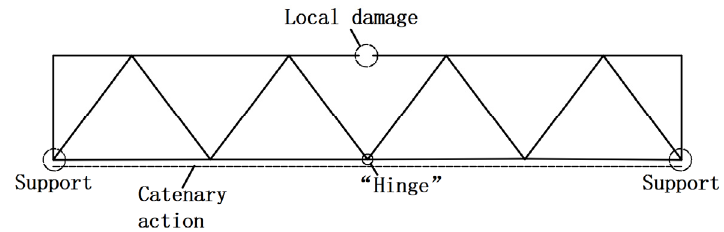
Figure 11. Catenary mechanism after the failure of the upper chord. The failure of the lower chord is similar to that of the upper chord. A hinge is developed directly above the damaged element. At this time, the remaining structure relies on the arch effect developed in the upper chords to provide a vertical bearing (Figure 12).